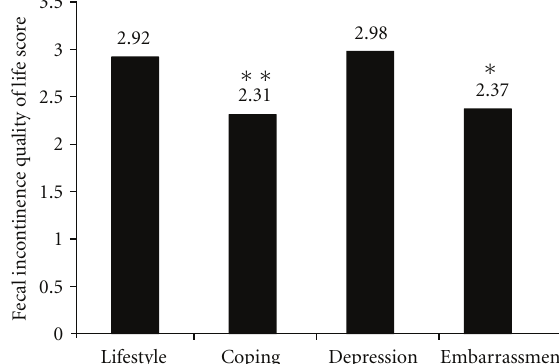
Figure 2: FIQL scores. ∗ Significantly lower than lifestyle and depression scales ( P < 0 . 006); ∗∗ Significantly lower than lifestyle and depression scales ( P < 0 . 003).